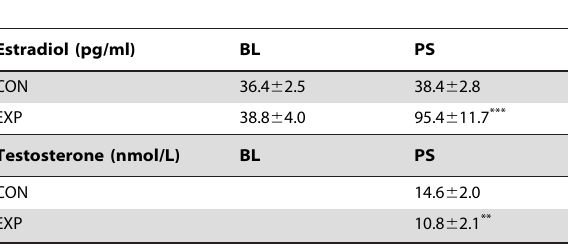
Table 2. Subject and eccentric exercise trial characteristics.